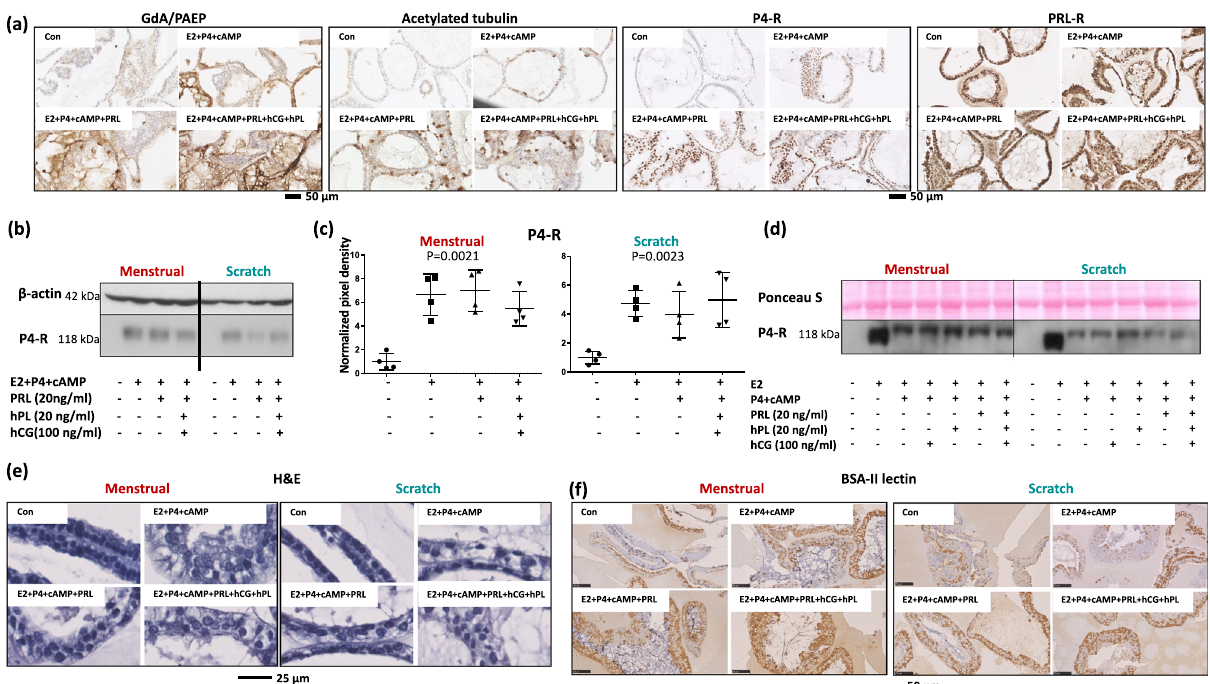
Fig. 3 Morphological changes in menstrual and scratch organoids in response to hormones. a Menstrual organoids show immunohistochemical upregulation of PAEP/GdA, acetylated tubulin, progesterone receptor (P4-R) and prolactin receptor (PRL-R) in response to hormones as organoids derived from pipelle biopsies. Scale bar 50 μ m. b , c Treatment of menstrual and scratch organoids ( n = 4 each) with different pregnancy hormones increased the expression of the progesterone receptor (P4-R), as detected by western blotting ( a ) and quanti fi ed ( b ). Statistical signi fi cance was assessed using ANOVA, p -values are shown on each graph, error bars represent standard deviation. d Representative western blots of menstrual and scratch organoids treated with a range of pregnancy hormones, including oestrogen alone (E2), which induced major upregulation of the P4-R expression. Adding of P4 alone or in combination with other hormones reduced E2-induced P4-R expression. e Representative images of haematoxylin and eosin (H&E) staining of hormonally treated menstrual and scratch organoids from one patient, showing morphological differences between untreated vs. hormonally treated organoids. Scale bar 25 μ m. f Bandeiraea simplicifolia -II (BSA-II) lectin staining of semi-thin resin sections of menstrual and scratch organoids treated with hormones. Scale bar 50 μ